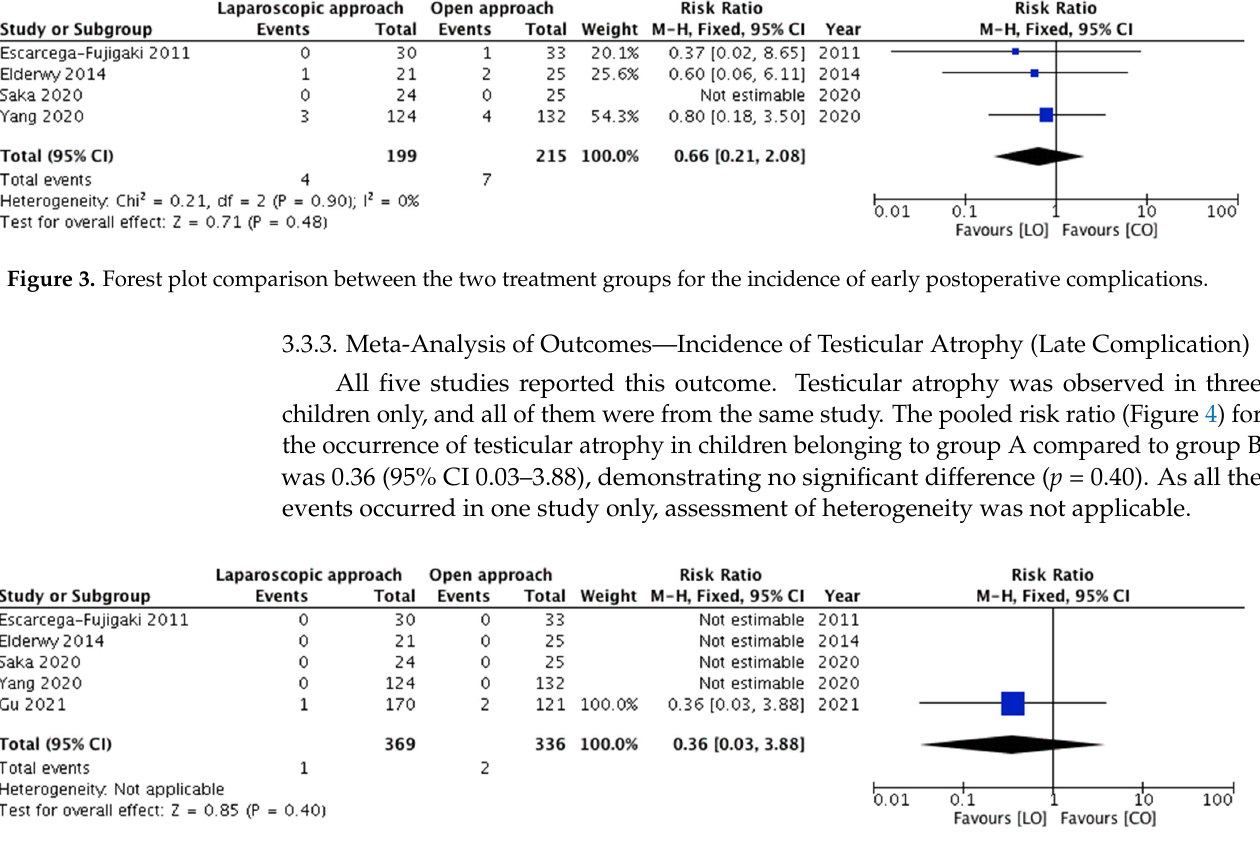
Figure 4. Forest plot comparison between the two treatment groups for the occurrence of testicular atrophy.